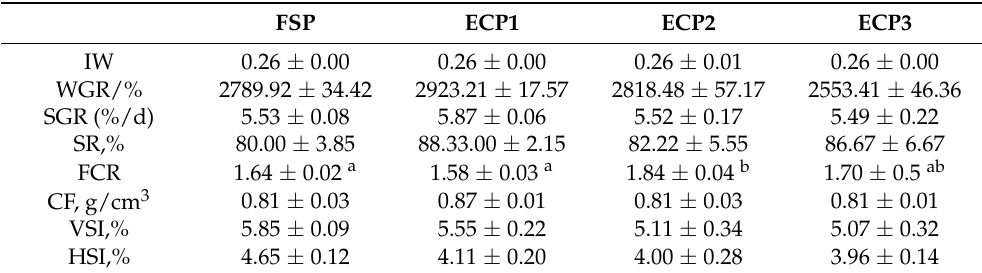
Table 4. Effect of fish soluble pulp meal and enzymatic chicken pulp on the growth and survival of L. vannamei .